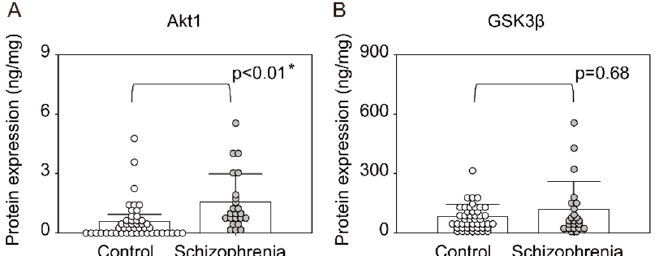
Figure 4. Expression levels of proteins downstream of phosphoinositide signaling pathway in the prefrontal cortex of patients with schizophrenia and controls. ( A ): Akt1, ( B ): GSK3 β . Means ± SD are shown as bars and whiskers. * p < 0.05. Table 1. Correlations between potential confounding factors (DOI and CPZeq) and protein expres- sion levels.